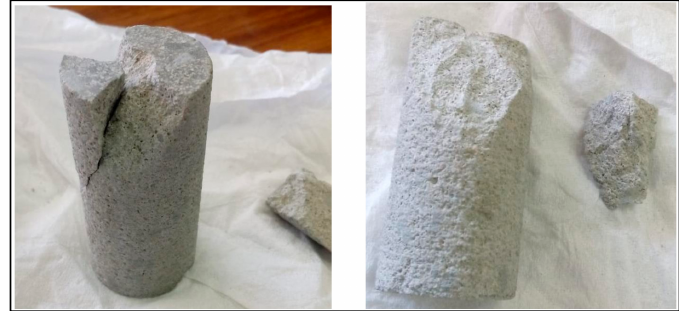
Figure 11. Fractured mortar sample after dynamic compression impact loading test (Brine-saturated case).